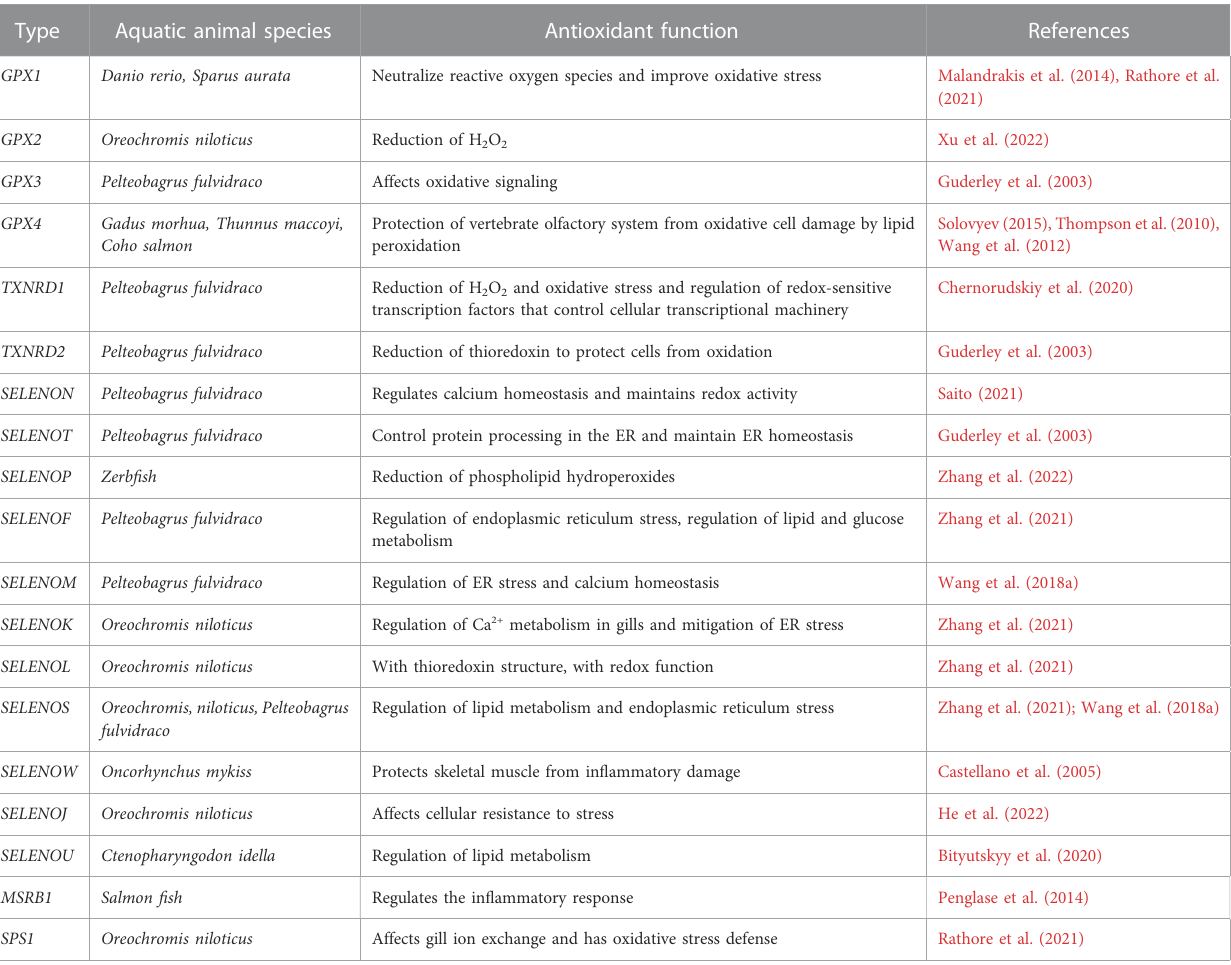
TABLE 1 Antioxidant functions of releated